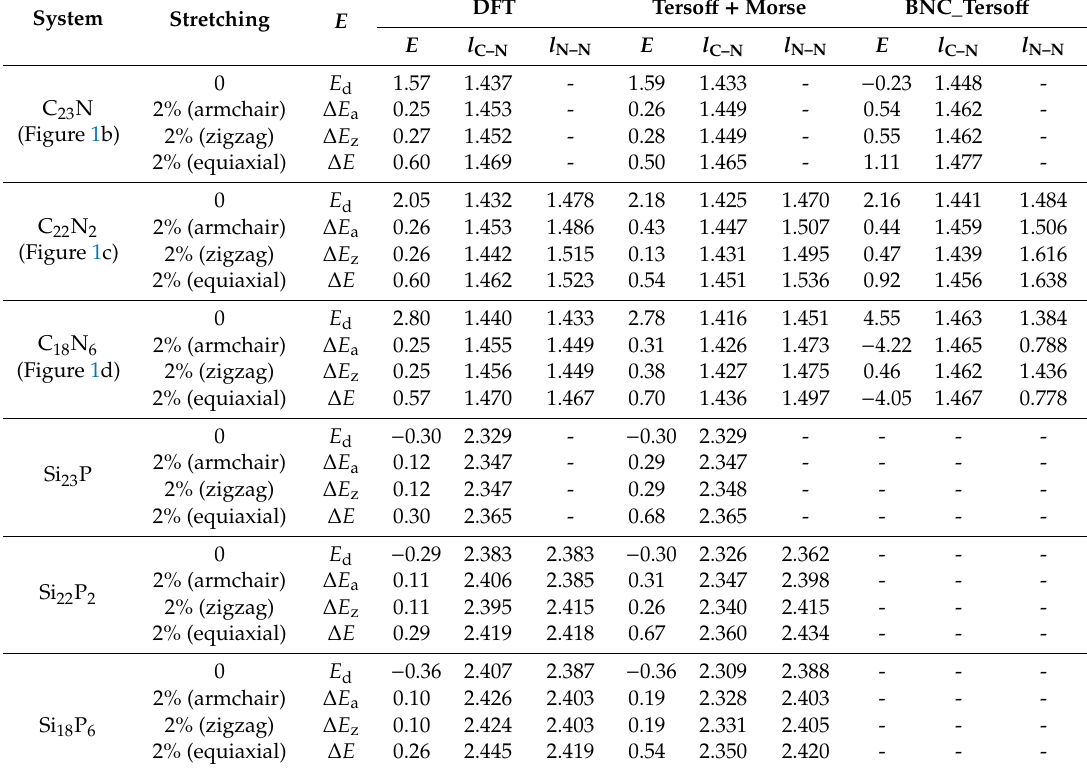
Table 1. Energies of the nitrogen defects, energy di ff erences, and average bond lengths calculated within the density functional theory and empirical force fields. All energies and lengths are in eV and Å, respectively. DFT: density functional theory.